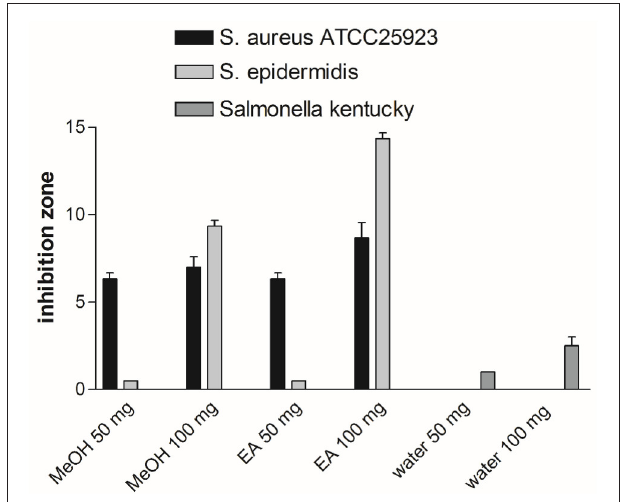
FIGURE 8 | Antimicrobial activity of methanol, ethyl acetate and water extracts of Ononis natrix against to S. aureus ATCC 25923, S. epidermidis and S.